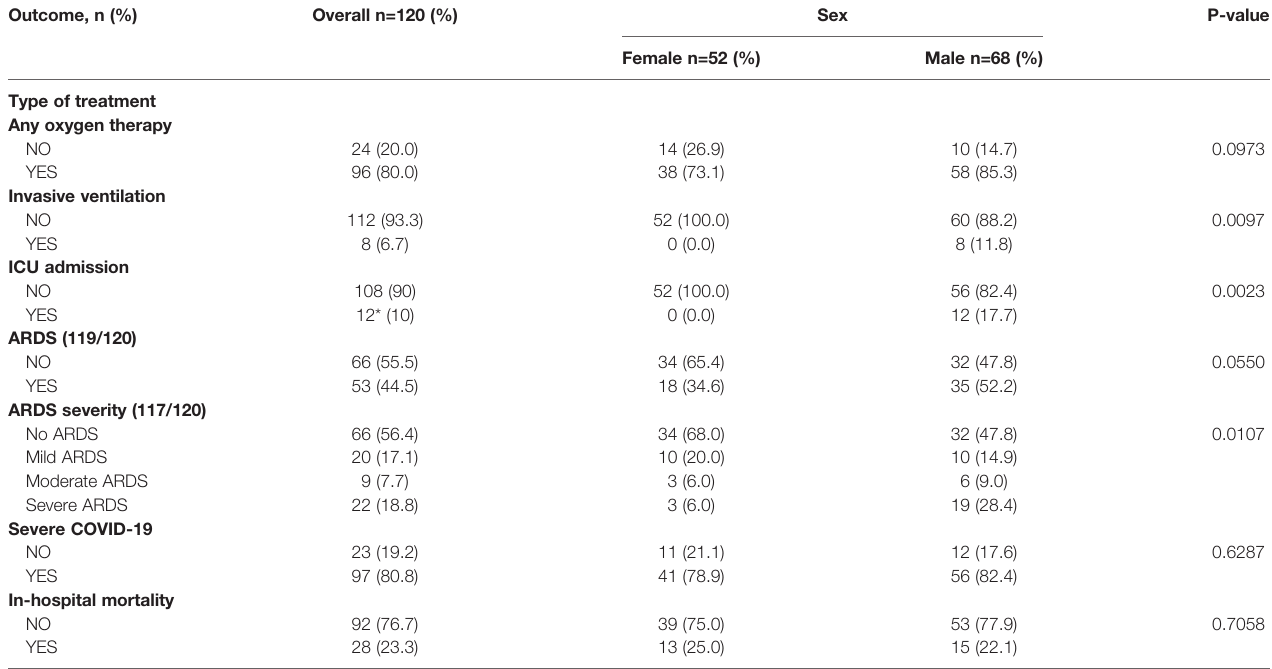
TABLE 3 | Type of respiratory support (oxygen therapy and invasive ventilation), ICU admission, and clinical outcomes (ARDS, severe COVID-19, and in-hospital mortality) of patients 50 years and over, strati fi ed by sex (if data are known on a subset of patients, the number is indicated in parenthesis after the variable name). Outcome, n